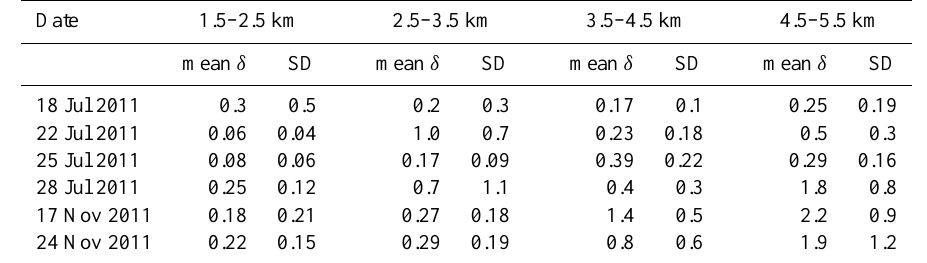
Table 2. Mean absolute deviation (mean δ ) and standard deviation (SD) of water vapour mixing ratio (gkg − 1 ) between lidar and radiosonde data at different layers.